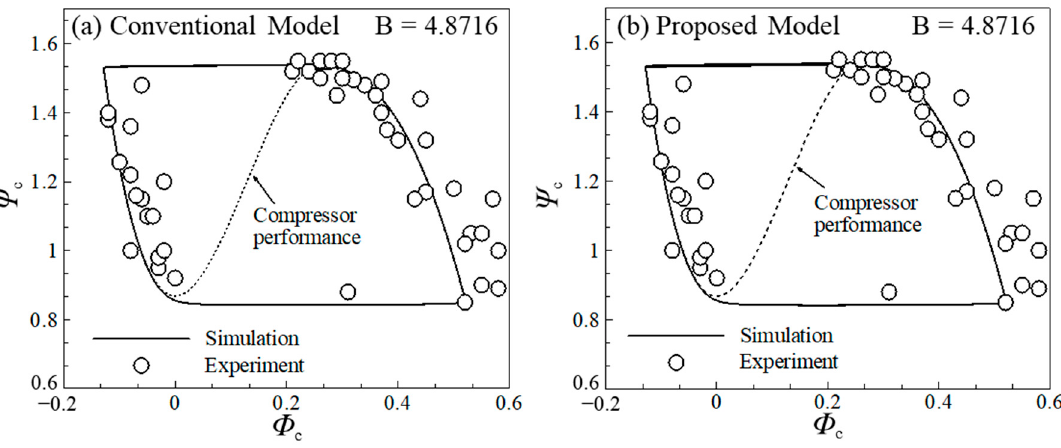
Figure 10. Comparison of the proposed model and the conventional model for surge parameter B = 4.8716.